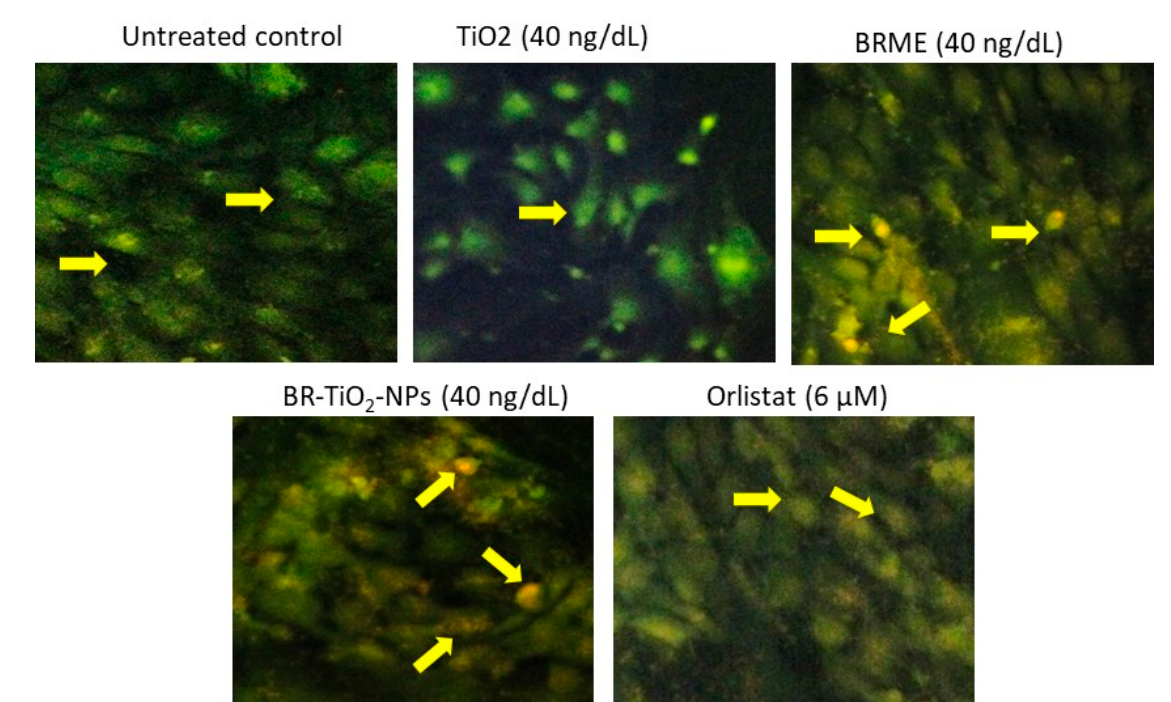
Figure 7. JC-1 staining analysis for mitochondrial membrane potential in the control adipocytes and the adipocytes treated with TiO 2 , BRME, and BR-TiO 2 -NPs for 14 days.